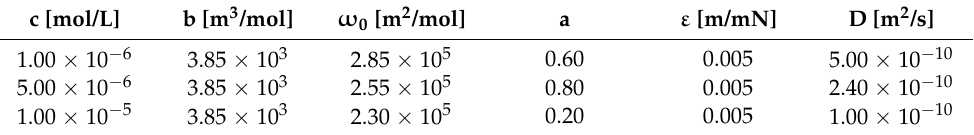
Table 7. Parameter values obtained by fitting the Frumkin adsorption model Equations (1)–(3) and the diffusion Equation (6) to the experimental data of Figure 7 as measured for equimolar solutions of NaC 16 SO 4 + C 12 TAB.